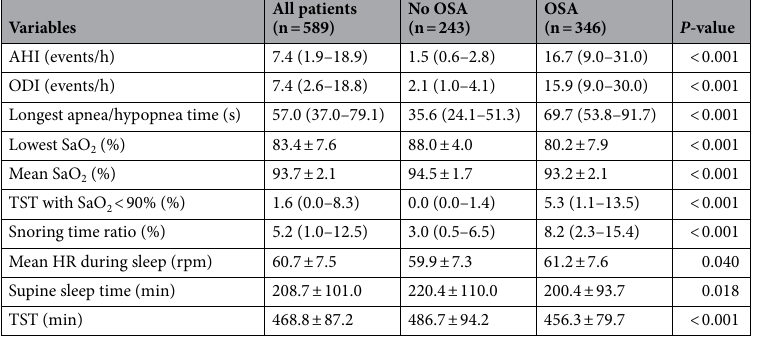
Table 2. Sleep data of patients with HCM grouped by the presence of OSA. Values are presented as mean ± standard deviation or as median (interquartile range). HCM: hypertrophic cardiomyopathy; OSA: obstructive sleep apnea; AHI: apnea hypopnea index; ODI: oxygen desaturation index; SaO 2 : oxygen saturation; TST: total sleep time; HR: heart rate.